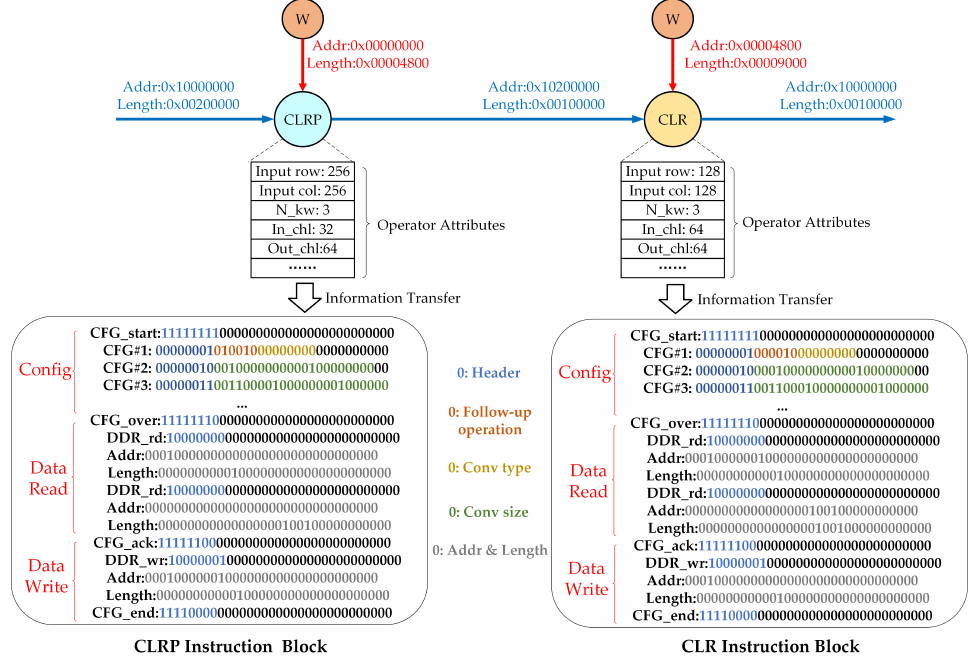
Figure 17. Diagram of the processing of mapping from compute graph to